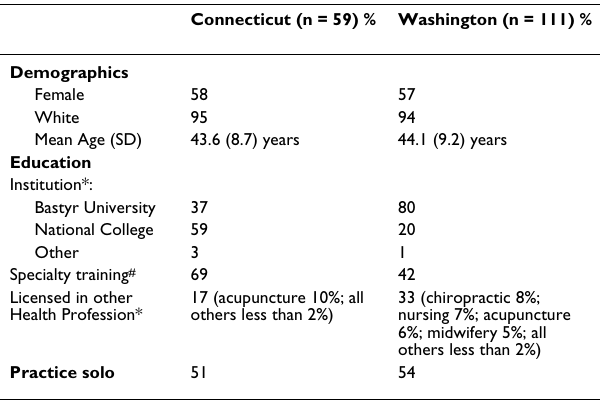
Table 2: Characteristics of naturopathic physicians licensed in Connecticut (1999) and Washington